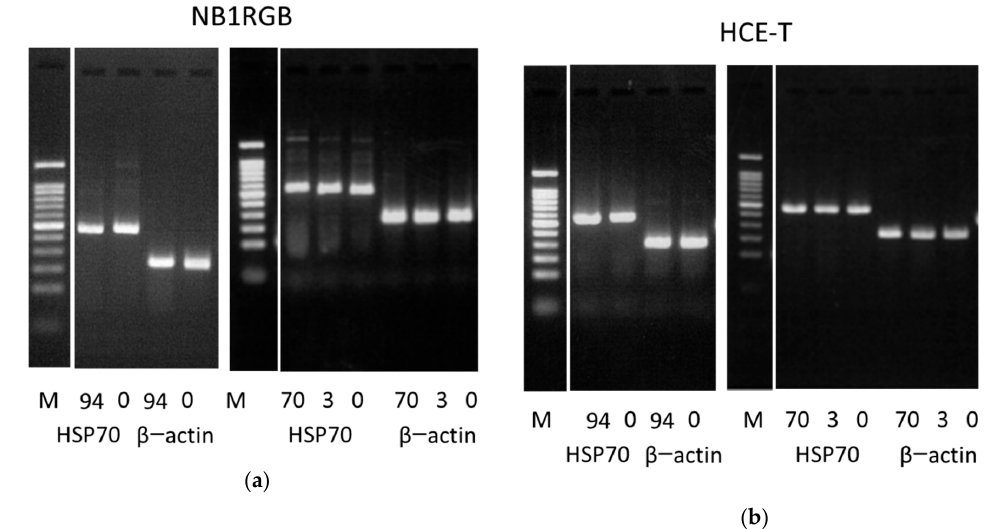
Figure 9. Level of HSP70 mRNA expression observed by RT-PCR for NB1RGB cell ( a ) and HCE-T cell ( b ). Lane M is a DNA molecule size marker. Lane 70 shows cells exposed for 70 h during cells. β -actin was used as an internal standard.